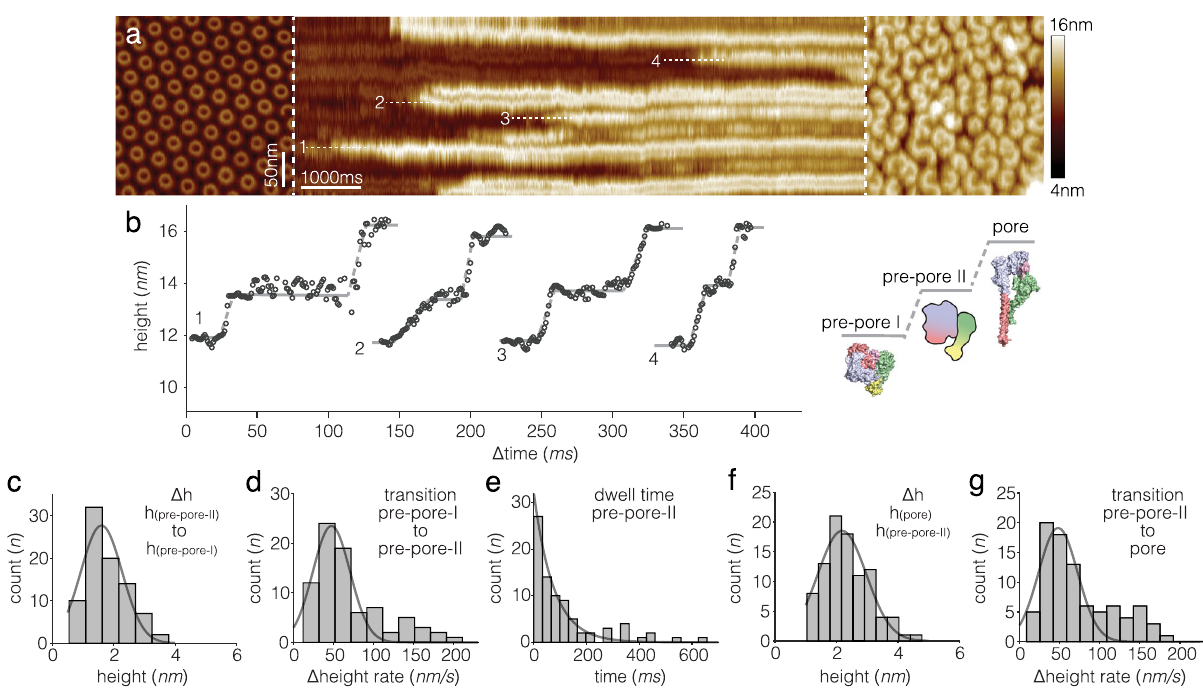
Fig. 6 | HS-AFM line scanning (HS-AFM-LS) with millisecond temporal resolu- tion of PFN2 subunit pre-pore to pore transition. a Left: HS-AFM image of PFN2 pre-pore oligomers (rings) before HS-AFM-LS. Center: HS-AFM-LS of PFN2 pre- pore-to-pore transition (line acquisition rate: 500 lines/s, 2ms/line temporal reso- lution). Right: HS-AFM image of PFN2 pore oligomers (arcs) after HS-AFM-LS (experimental repeats, n =20). b Height pro fi les 1 – 4 of subunit pre-pore-I to pre- pore-II to pore transitions along the dashed lines 1 – 4 in a . Inset: cartoon of PFN2